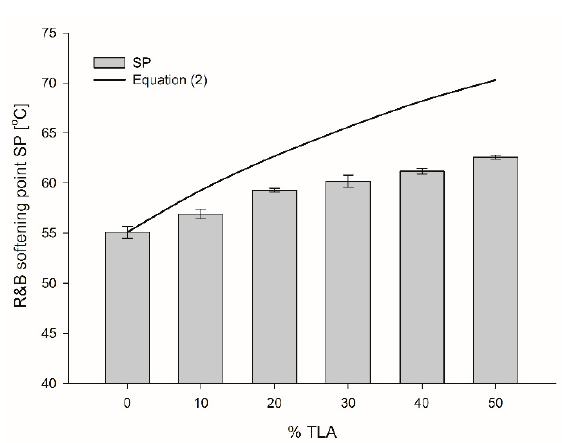
Figure 1. Penetration of TLA-modified binders.